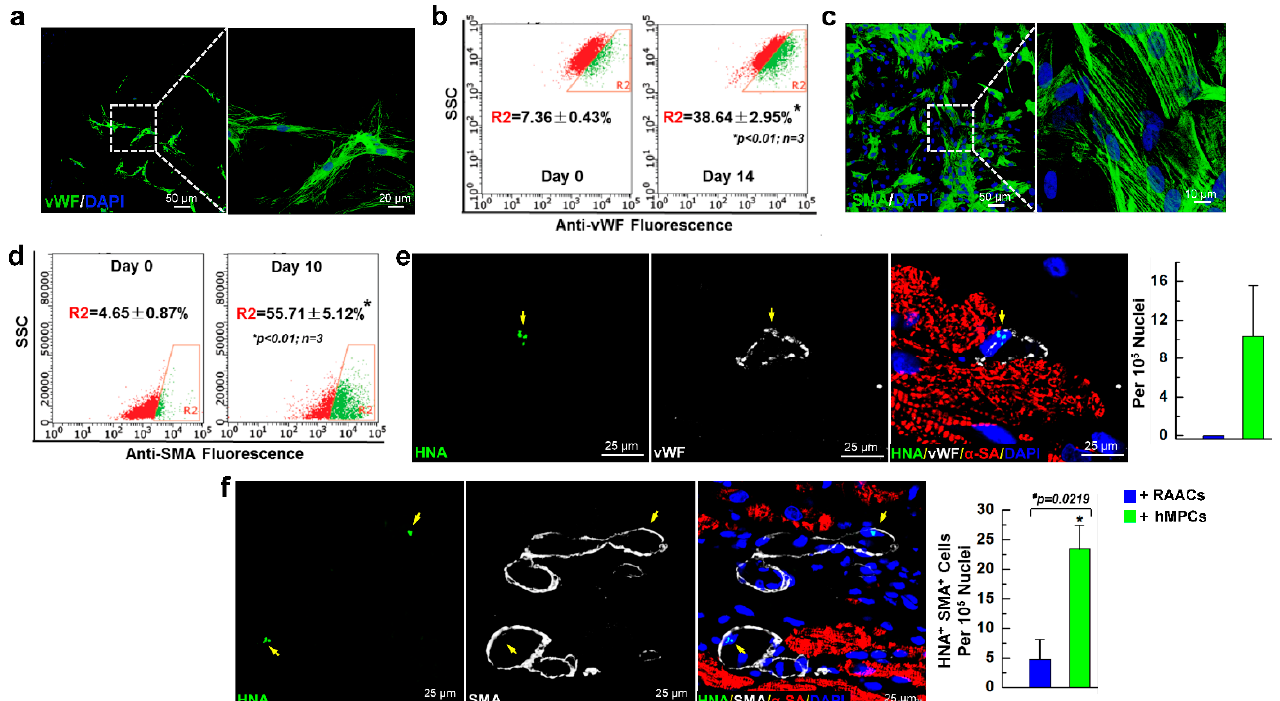
Figure 6. The hMPCs have an ability to differentiate into vascular cells both in vitro and in vivo. ( a ) Representative images of endothelial cells that were differentiated from hMPCs after staining with the von Willebrand factor (vWF, green) endothelial cell maker and DAPI (blue). ( b ) Flow cytometer analysis for vWF positive cells after 14 days of differentiation from hMPCs. ( c ) Representative images of smooth muscle cells that were differentiated from hMPCs after staining with smooth muscle actin (SMA, green) and DAPI (blue). ( d ) Flow cytometer analysis for SMA positive cells after 10 days of differentiation from hMPCs. ( e ) Immunofluorescent staining for the risk area of the infarcted heart with vWF and human nucleic marker (HNA); cells with double-positive staining (yellow arrow) indicate the endothelial cells that were derived from transplanted hMPCs. Quantitative analysis shown in the right panel. The y-axis represents the number of HNA + vWF + cells per 10 5 nuclei. ( f ) Immunofluorescent staining for the risk area of the infarcted heart with SMA and HNA; cells with double-positive staining (yellow arrow) indicate the smooth muscle cells that were derived from transplanted hMPCs. Quantitative analysis shown in the right panel. The y-axis represents the number of HNA + SMA + cells per 10 5 nuclei. Note: 6 mice for each group; 20 images were taken for each section. Data are means ± SEM; * p < 0.05, unpaired students’ t -test.